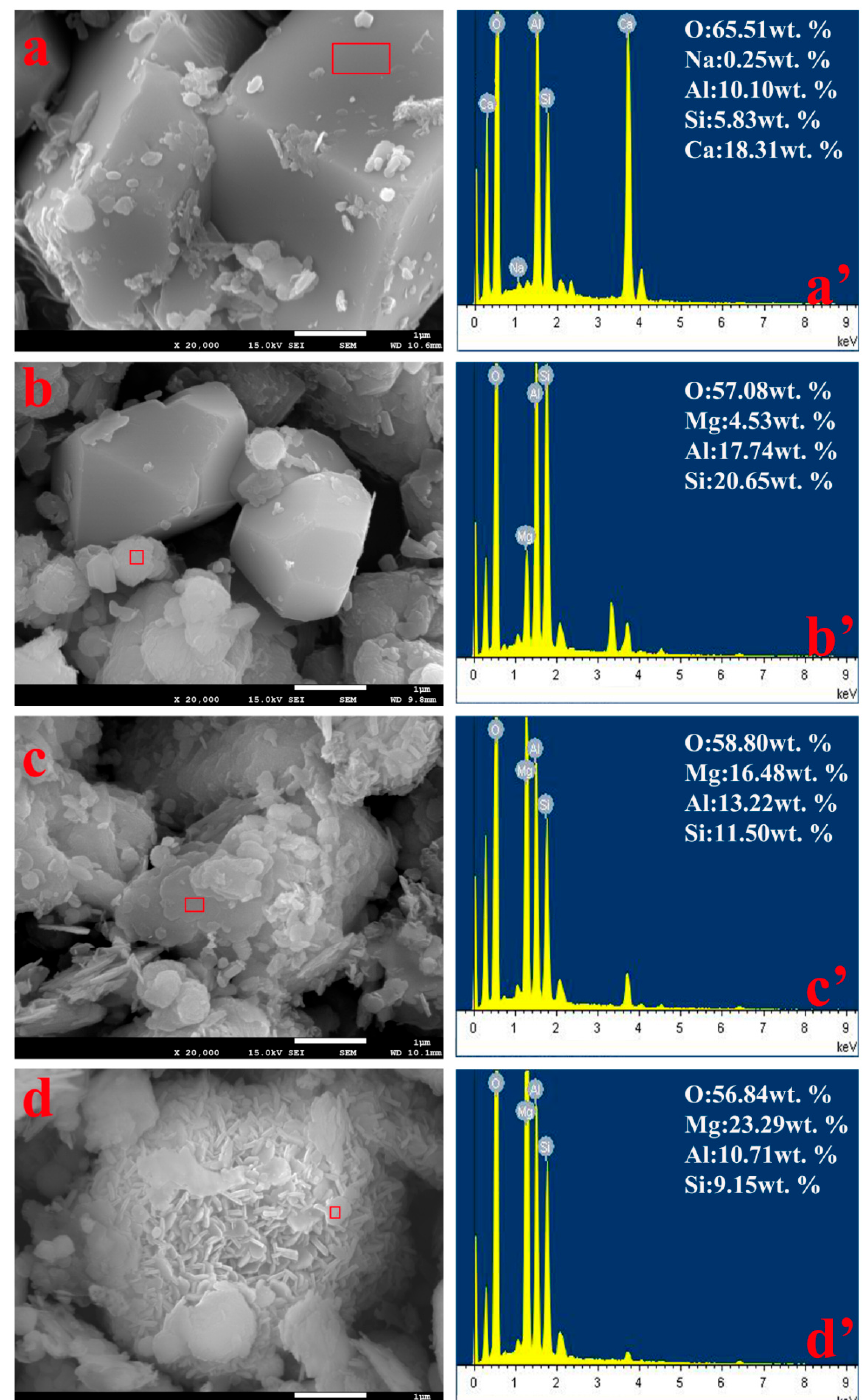
Figure 9. Morphologies of the solid products at 200 ◦ C: ( a - a’ ) 0% MgO addition; ( b - b’ ) 30% MgO addition; ( c - c’ ) 70% MgO addition and ( d - d’ ) 100% MgO